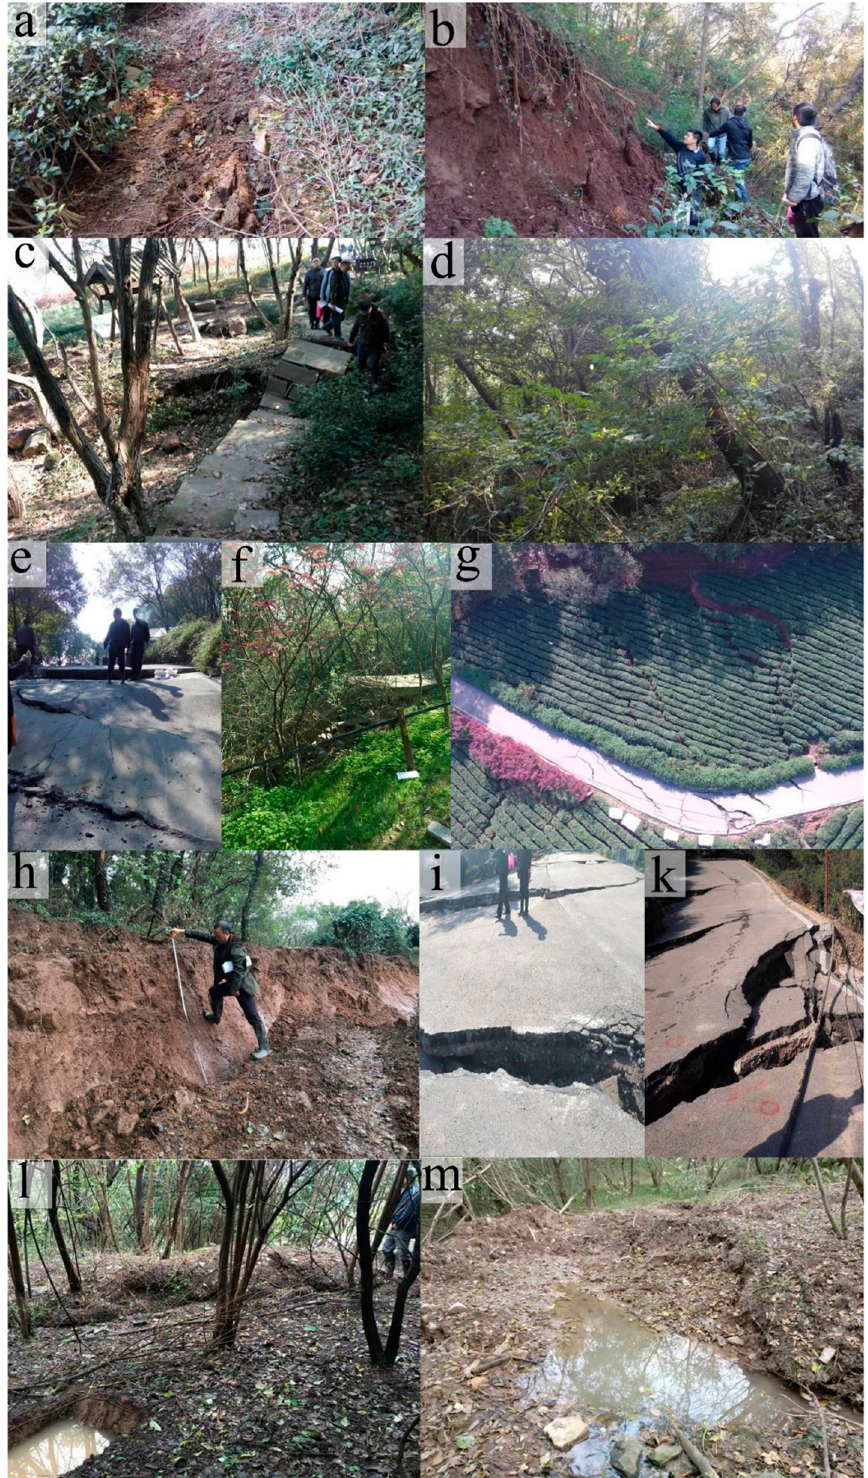
Figure 4. ( a ) Scarp on the trailing edge of landslide, photographed 23 September 2016; ( b ) scarp on the trailing edge of landslide, photographed 3 November 2016; ( c ) broken mountain road; ( d ) toppled trees; ( e ) cracks on Dlinglin Road; ( f ) deformation of retaining wall; ( g ) groove on the northwest side of landslide; ( h ) subsidence of groove [16]; ( i ) cracks on Zulong Road; ( k ) cracks on Dinglin Road; ( l ) front shear outlet; ( m ) groundwater flowing out of the surface, their positions are shown in Figure 5.